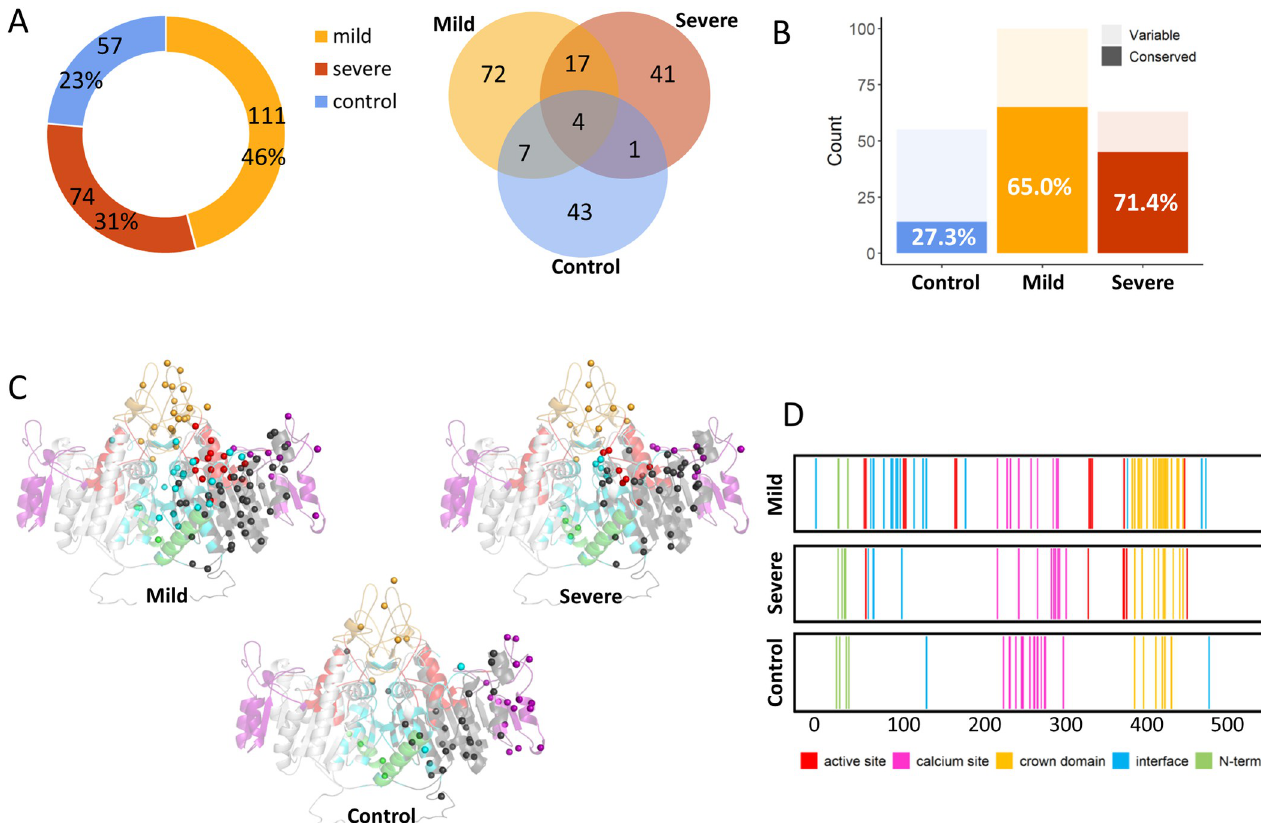
Fig 2. Sequence and structural analysis of ALPL mutations in the TNSALP protein. (A) The composition and statistics of ALPL mutations of based on the three categories: mild HPP, severe HPP, and control group. (B) The conservation distribution of mutations related to different phenotypes. (C) The structure of the TNSALP protein and the distribution of mutation sites in the active site (red), calcium site (purple), crown domain (brown), dimeric interface (blue), and N-terminal domain (green). Missense mutations in the three groups are shown as colored spheres based on the coloring scheme of the domains to which they belong. (D) Distribution of different clinical phenotypic mutations across the length of the TNSALP protein.